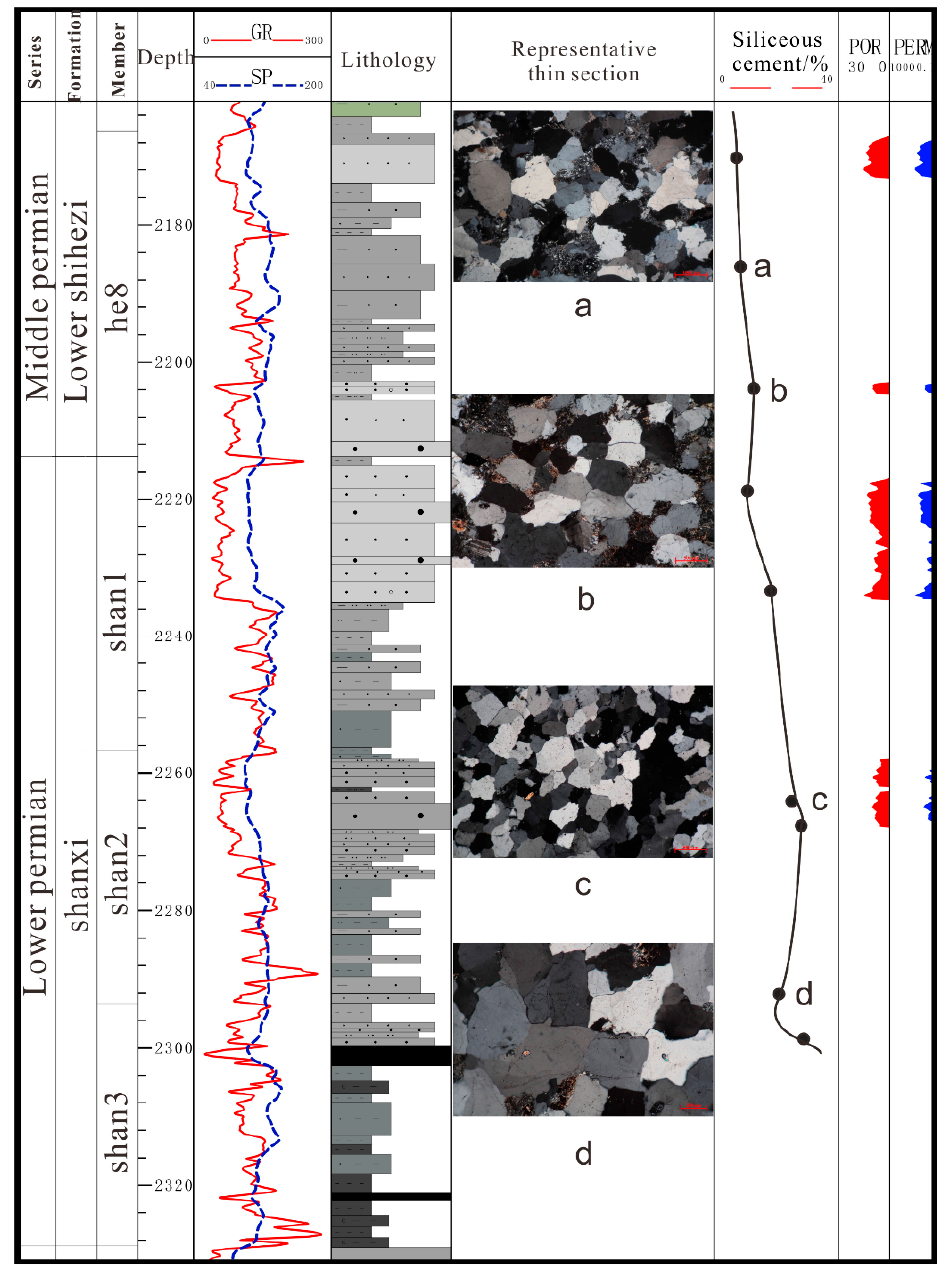
Figure 2. Comprehensive strata log diagram.